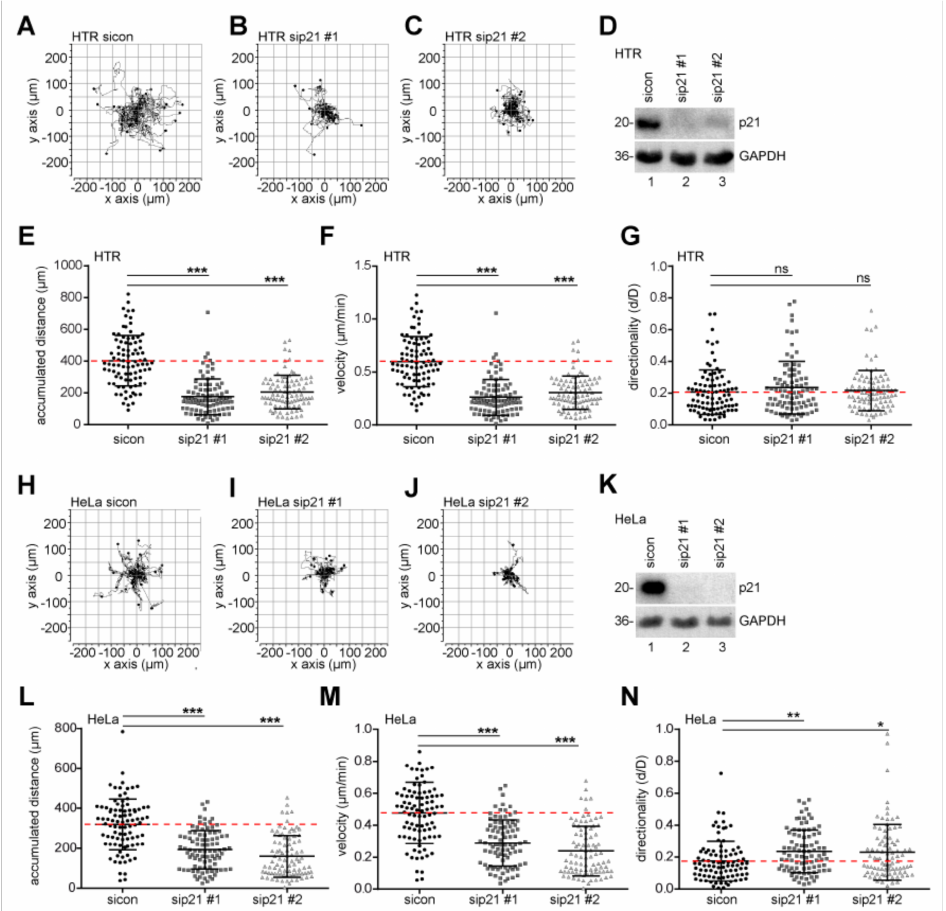
Figure 3. p21 is required for cell motility. Single-cell tracking using time-lapse microscopy was performed with treated HTR cells. ( A – C ) Representative trajectories of individual cells ( n = 30) treated with sicon (A), sip21 #1 ( B ), or sip21 #2 (C) are shown. ( D ) Control Western blot analysis shows the e ffi cient knockdown of endogenous p21 in HTR cells. Glyceraldehyde-3-phosphate dehydrogenase (GAPDH) served as loading control. ( E – G ) Accumulated distance (E), velocity (F), and directionality ( G ) of these cells were analyzed and statistically evaluated from three independent experiments. The results are shown as scatter plots. *** p < 0.001. ( H – J ) Representative trajectories are shown for individual HeLa cells ( n = 30) with sicon ( H ), sip21 #1 ( I ), and sip21 #2 (J). ( K ) Control Western blot analysis of HeLa cells. GAPDH served as loading control. ( L – N ) Accumulated distance (L), velocity (M), and directionality (N) were evaluated. The data are derived from three independent experiments and shown as scatter plots. * p < 0.05, ** p < 0.01, *** p <